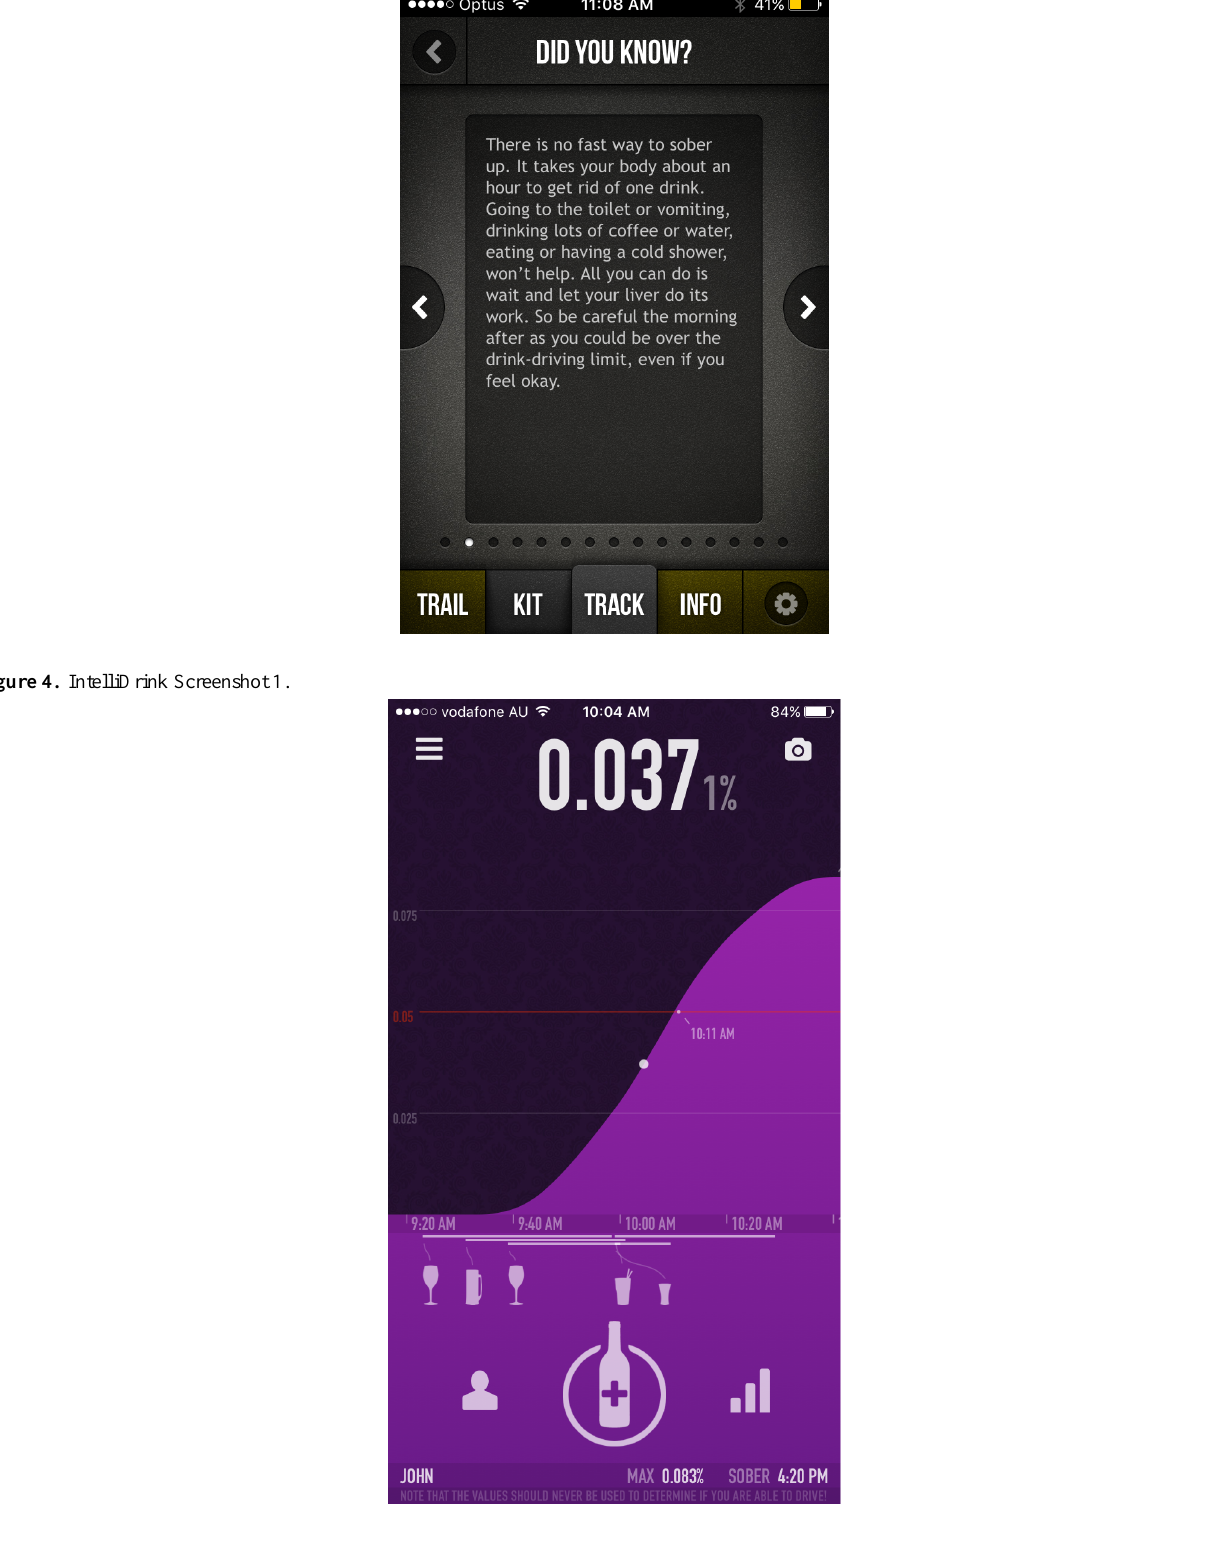
Figure 3. OnTrack Screenshot 2.